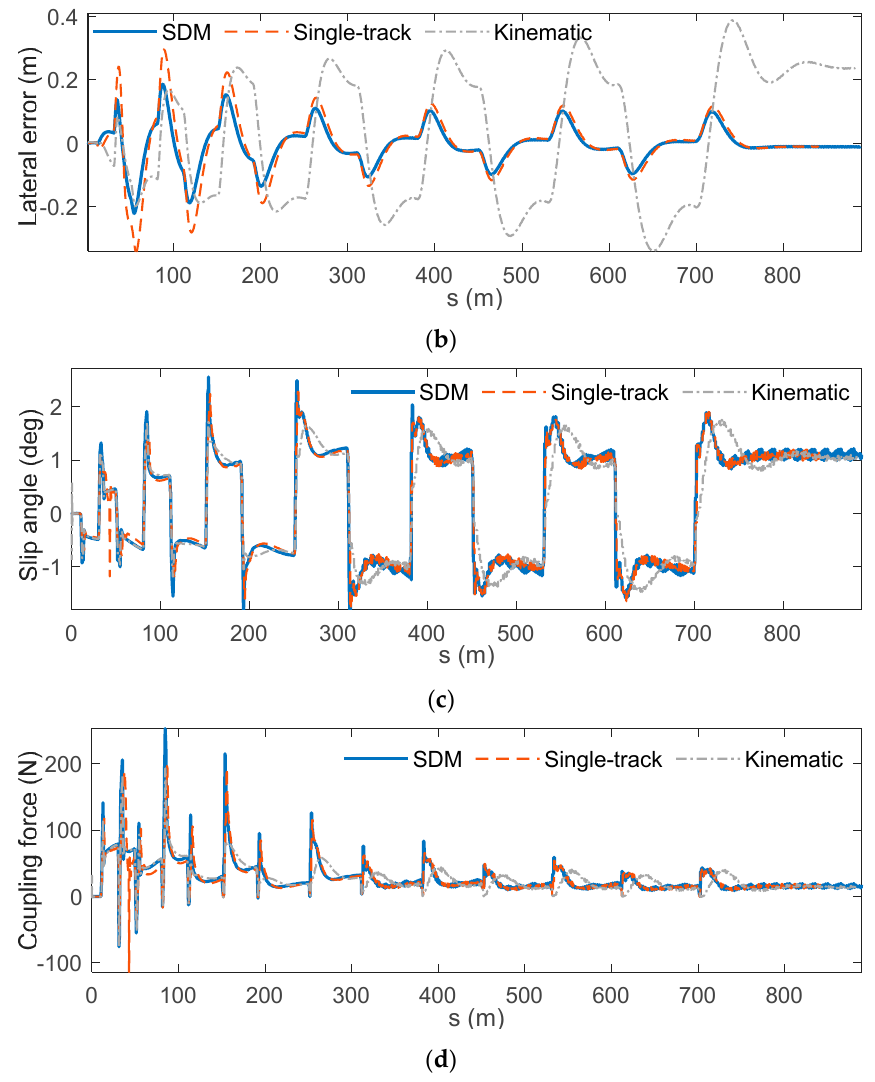
Figure 9. Results of SCENARIO 1. ( a ) Longitudinal speed. ( b ) Lateral error. ( c ) Slip angle of front tire. ( d ) Longitudinal coupling component.